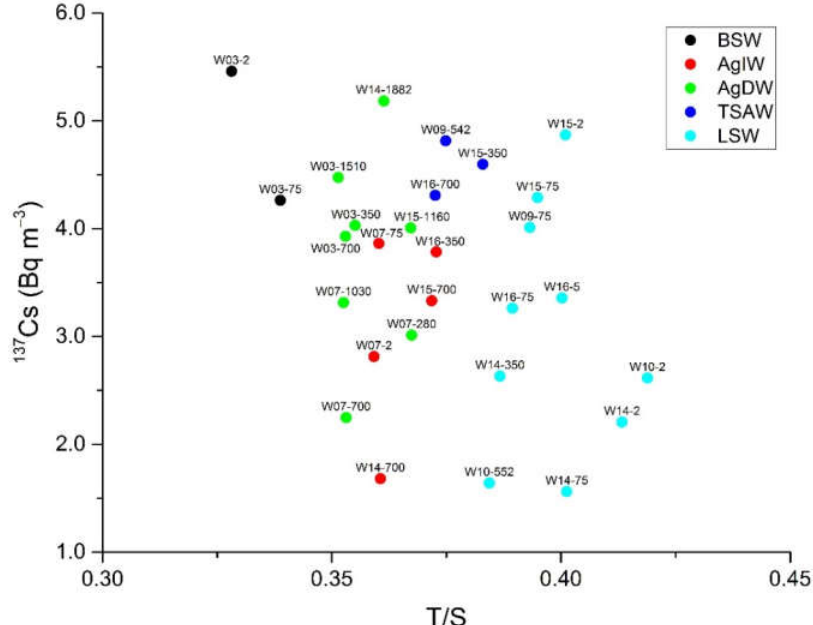
Figure 5. 137 Cs activity concentrations against T/S diagram for the measured water samples. Each sample is labeled with the sampling station name and depth, while the color represents the corre- sponding water mass as derived from Figure 4 (water mass definitions are in the text).